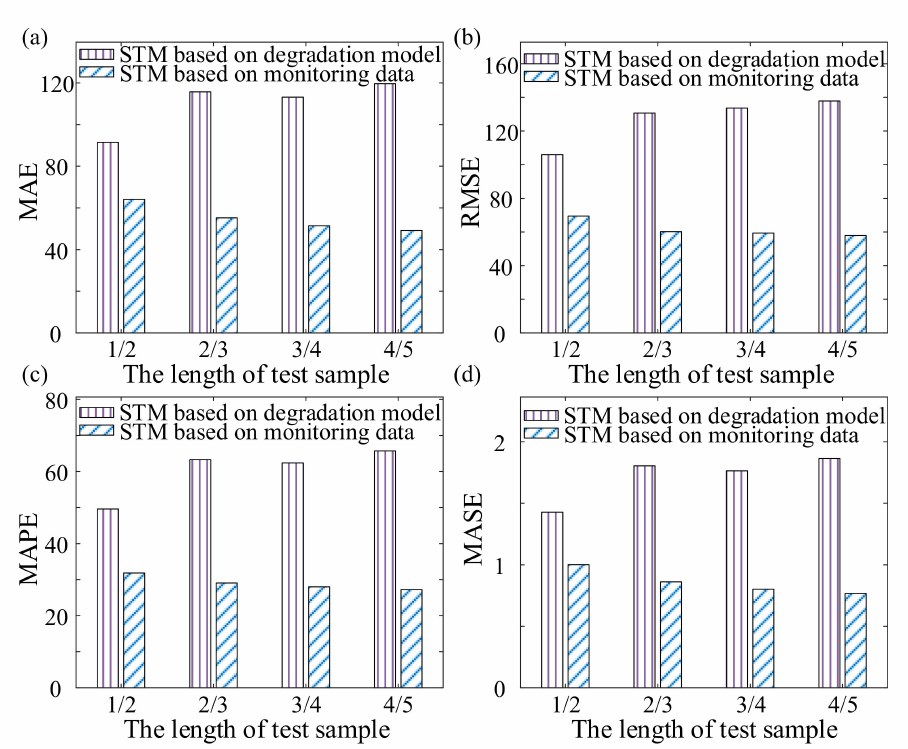
Figure 6. MAE, RMSE, MAPE, and MASE results of Set #2 based on the different test dataset.